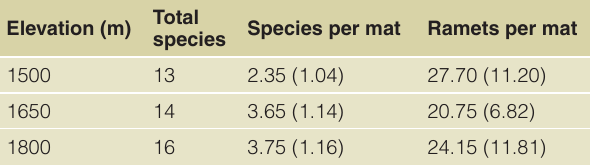
Table 8. Species richness or morpho-species and ramet density of mats surveyed in 2005. Per mat values are means with standard error in